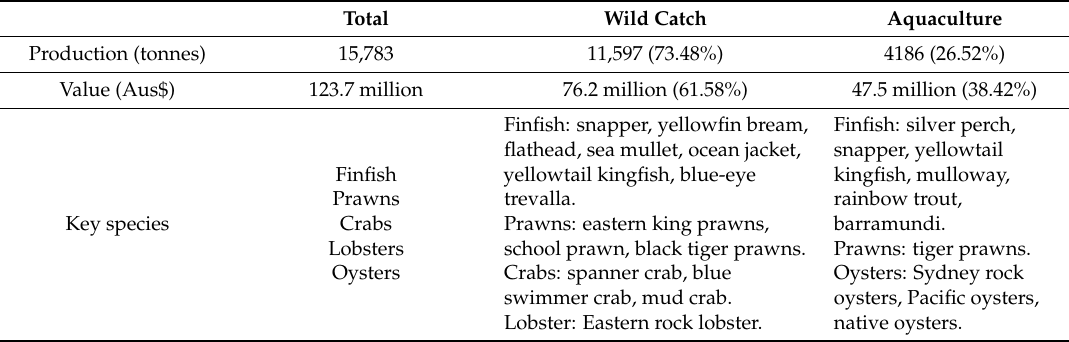
Table 1. Profile of New South Wales (NSW) seafood industry 2012–2013